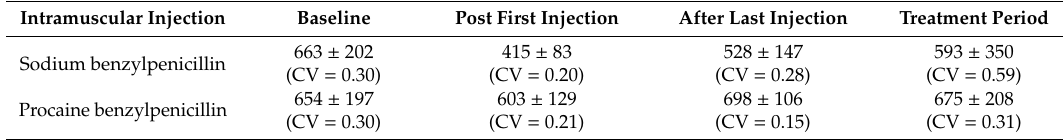
Table 15. MNT values (kPa) in response to intramuscular injections